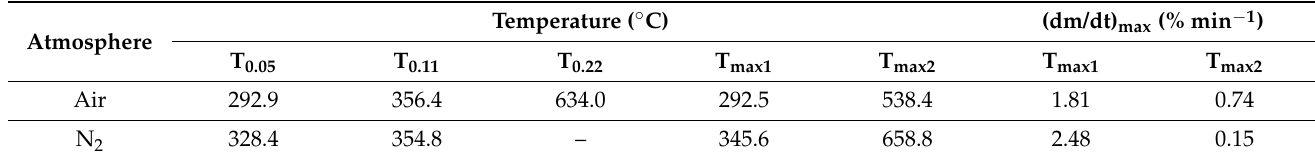
Table 1. Thermal decomposition data of the fibers/epoxy under different